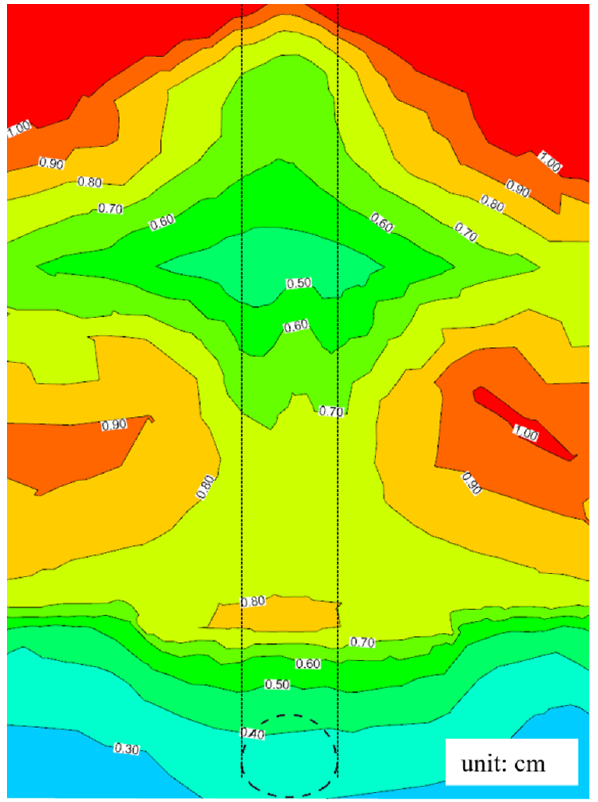
Figure 12. Loess-bedrock interface deformation contour calculated by the numerical simulation. The numerical simulation results show that the soil on both sides of the cave entrance was deformed in the middle (Figure 13a), indicating that although the soil should have slid downwards along the loess-bedrock sliding surface during the test, the presence of the tunnel structure meant that the direction of the loess movement was changed, and that the soil above the tunnel rose while the soil on both sides was deformed in the middle. Figure 13b also shows that the vertical deformation of the soil on both sides of the tunnel was clearly larger than that of the soil above the tunnel structure. The tunnel changed the movement path of the soil, making the soil on both sides move to the middle, and the soil exhibited a linear uplift and parallel cracking, as shown in Figure 14a. Through lateral observation and comparison with the initial state (Figure 14b), the uplift deformation of the upper soil of the tunnel can be clearly seen, whereas the bottom uplift was